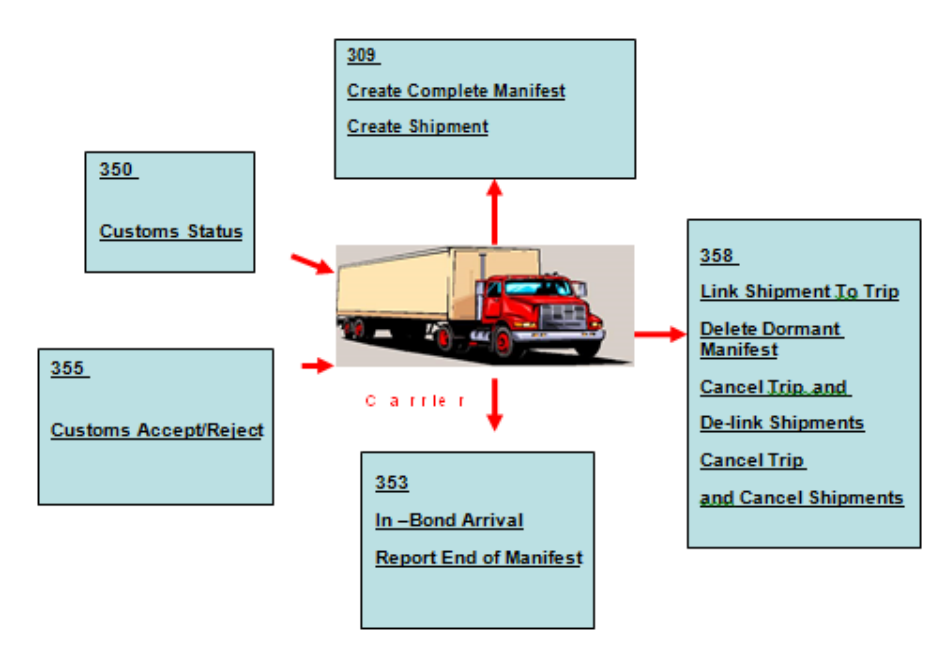
Figure 8. Manifest filing using